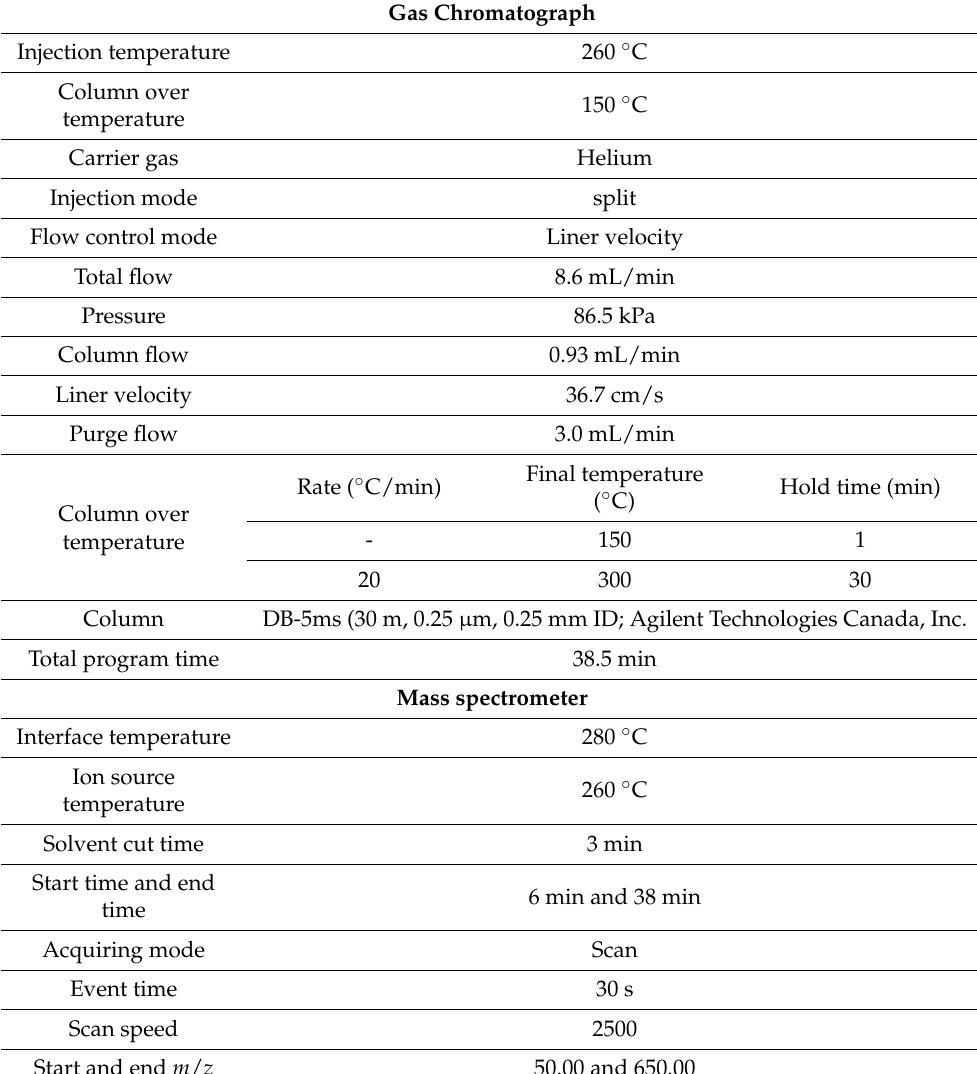
Table 3. GC-MS conditions used for the analysis of